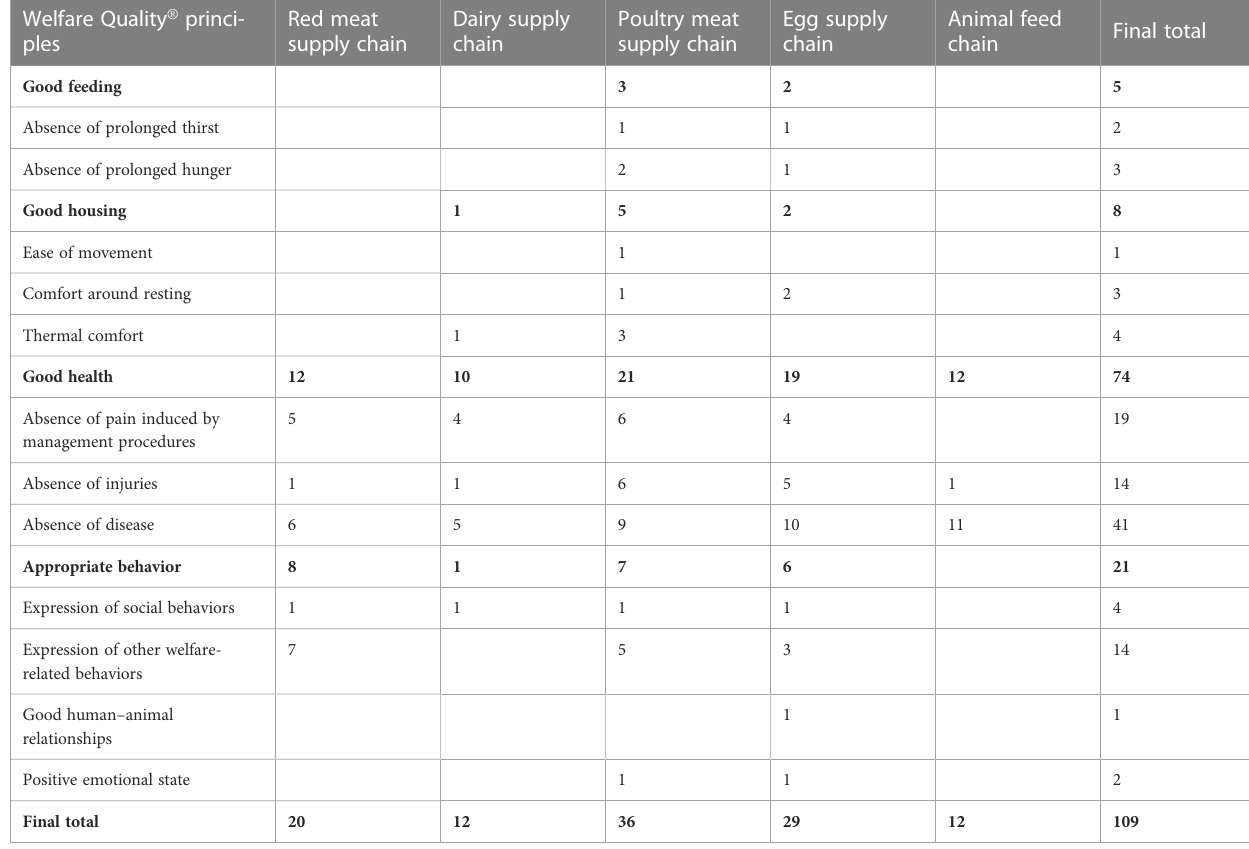
TABLE 3 Number of welfare consequences identi fi ed in the red meat, dairy, poultry meat, egg, and animal-feed supply chains (BuRO, 2015; BuRO, 2017; BuRO, 2019a; BuRO, 2019b; BuRO, 2019c; BuRO, 2019d), categorized in accordance with the Welfare Quality ® concept. Welfare Quality ®